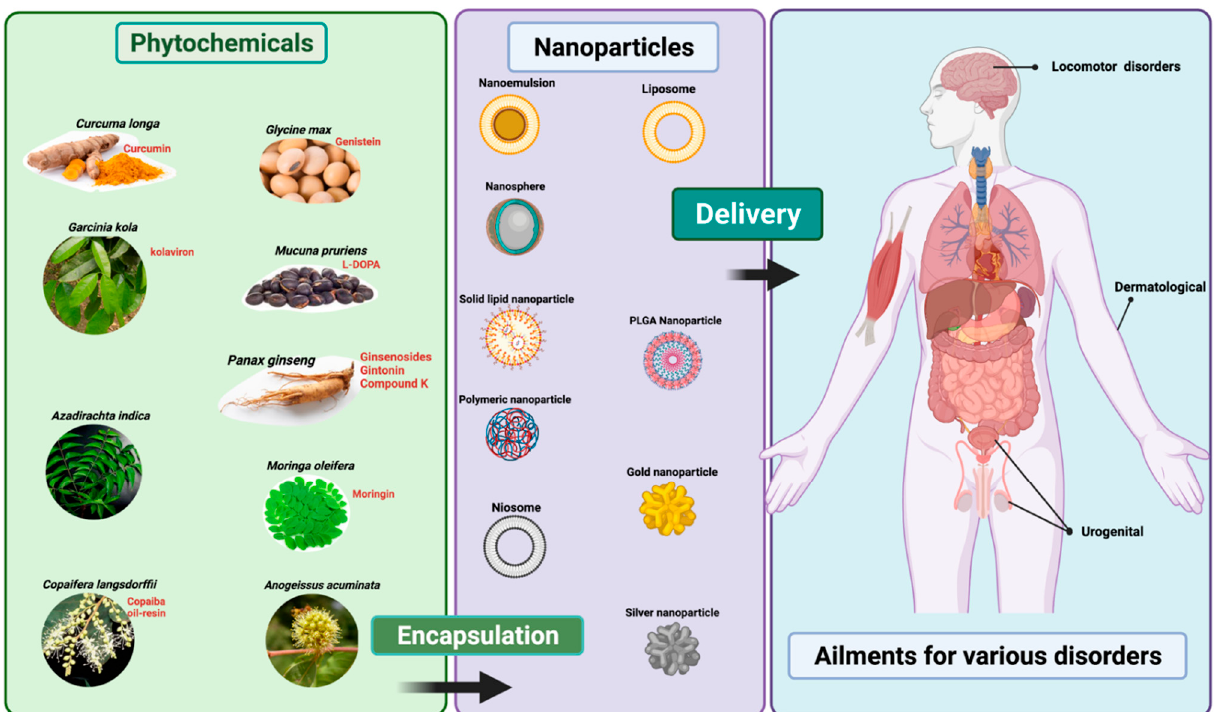
Figure 1. Representation of delivery of phytopharmaceutical using nanotechnology. The figure was made with www.biorender.com (access date: 15 March 2022).